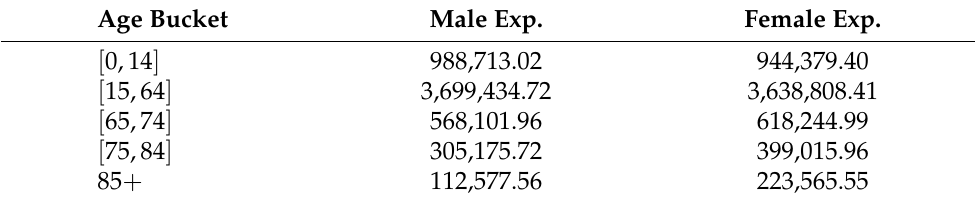
Table A2. The male and female Belgian exposures in 2020 in age buckets, obtained from STMF. Age Bucket Male Exp. Female